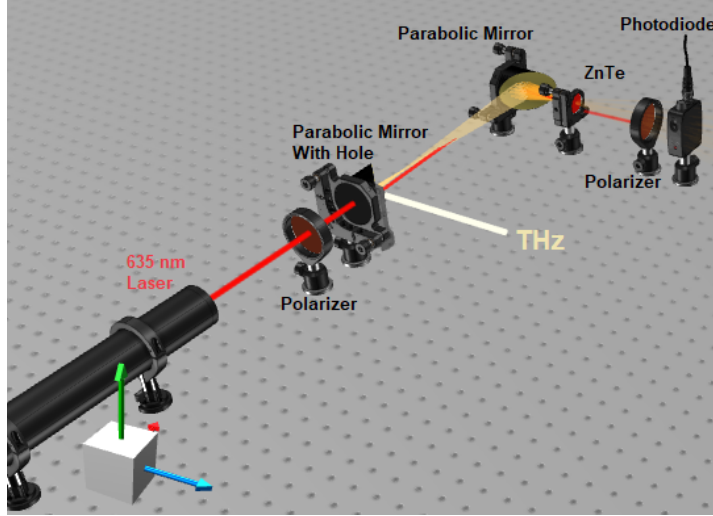
Figure 1. Schematic of the ZnTe electro-optic detector.